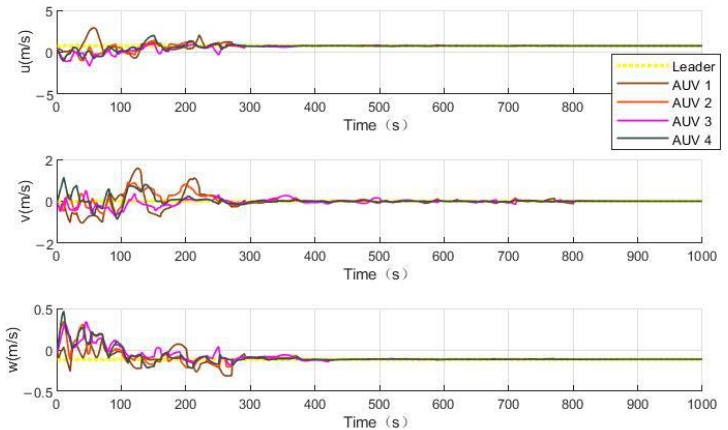
Figure 18. Attitude status of the AUV formation when using the controller in [13].